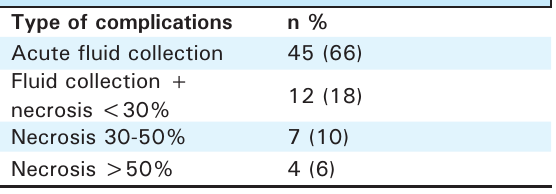
Table 3. Local complications (n=68).